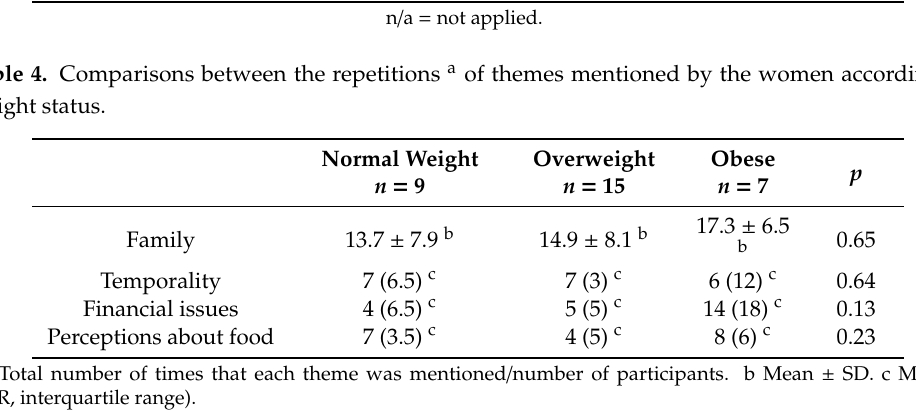
Normal Weight Overweight Obese p n = 9 n = 15 n = 7 100 100 100 n / a 100